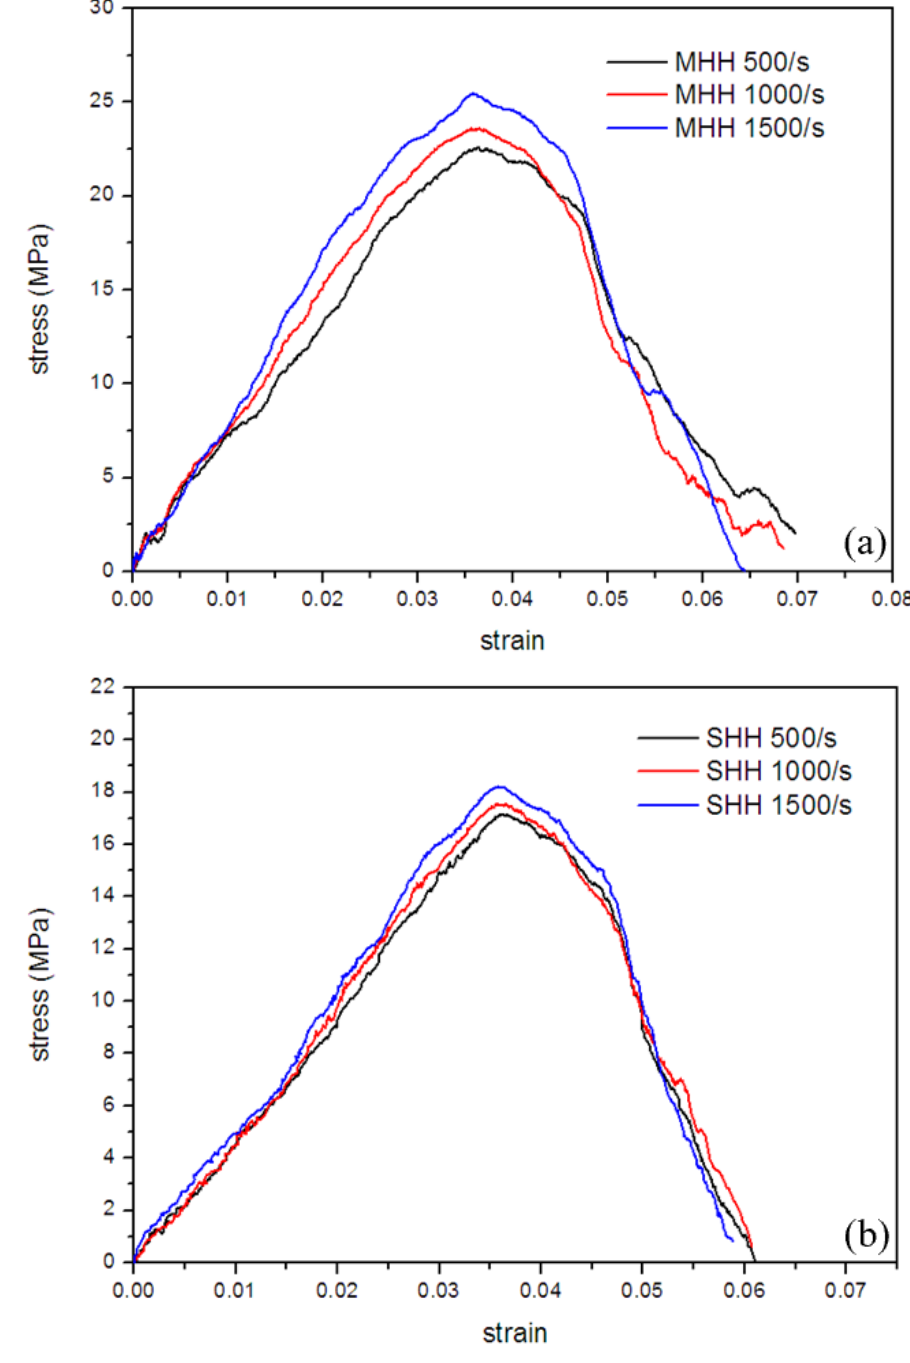
Figure 10. Dynamic stress–strain curve of resin hierarchical honeycomb materials: ( a ) MHH, ( b ) SHH. In the past, many scholars discussed the strain rate sensitivity of porous